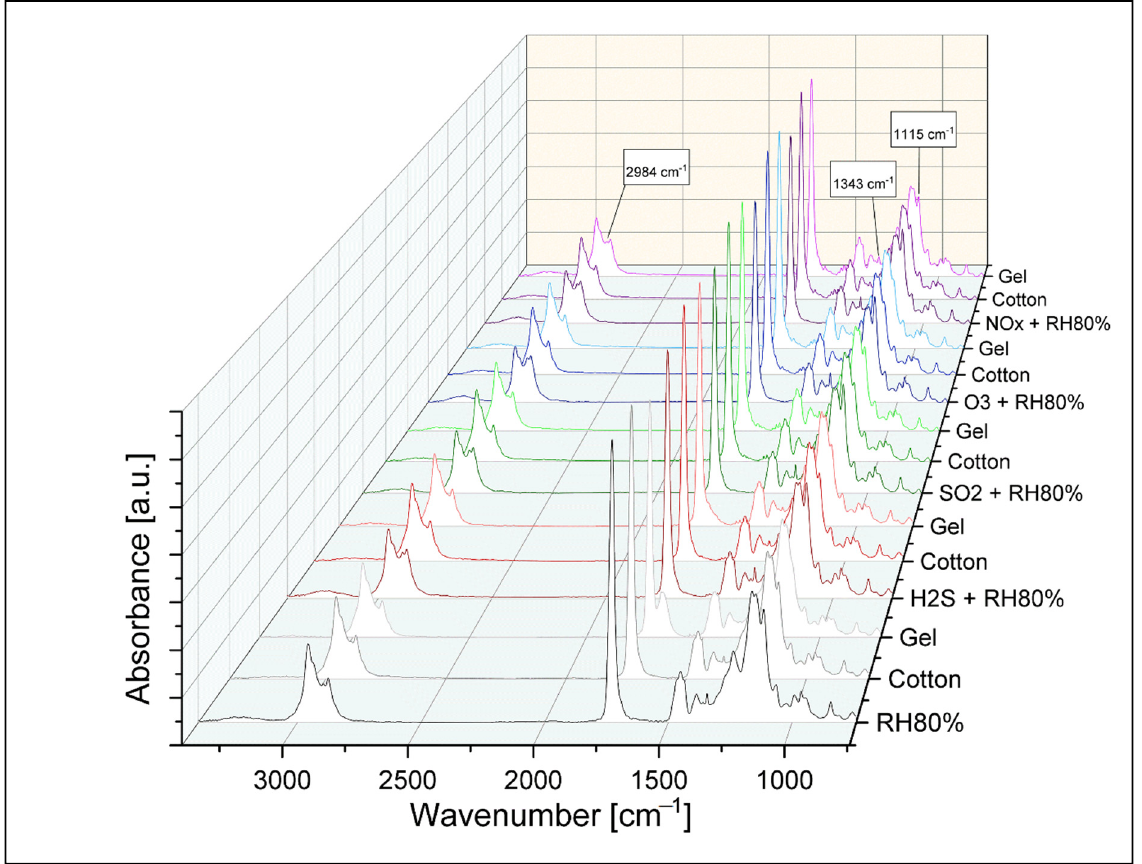
Figure 6. Comparison between ATR-FTIR spectra of aged samples and their surfaces after cotton swab rolling and gel test.